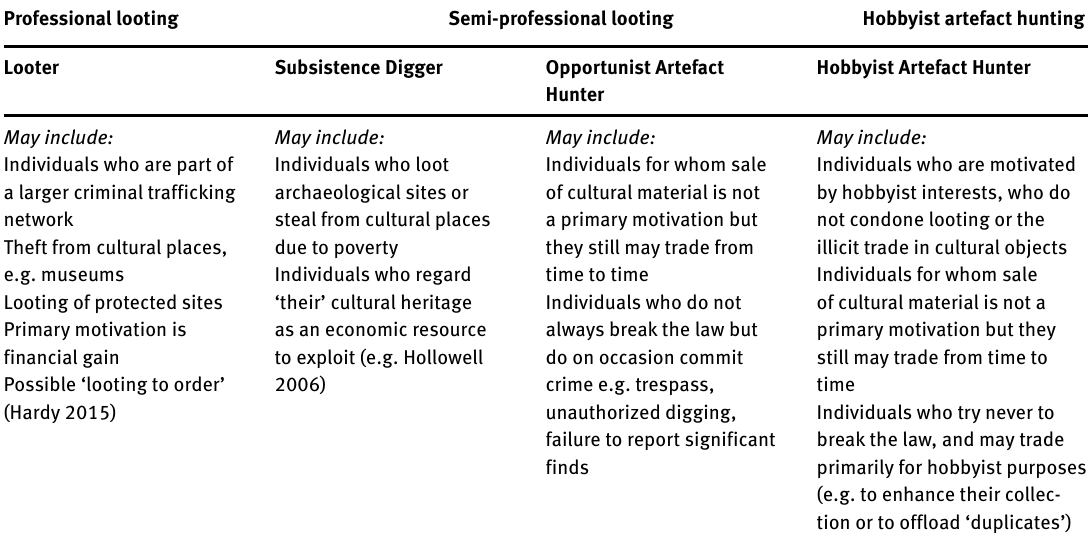
Table 1: A proposed ‘searching spectrum’ with Looting (criminal intent) at one end and Hobbyism/Leisure at the other. © Suzie